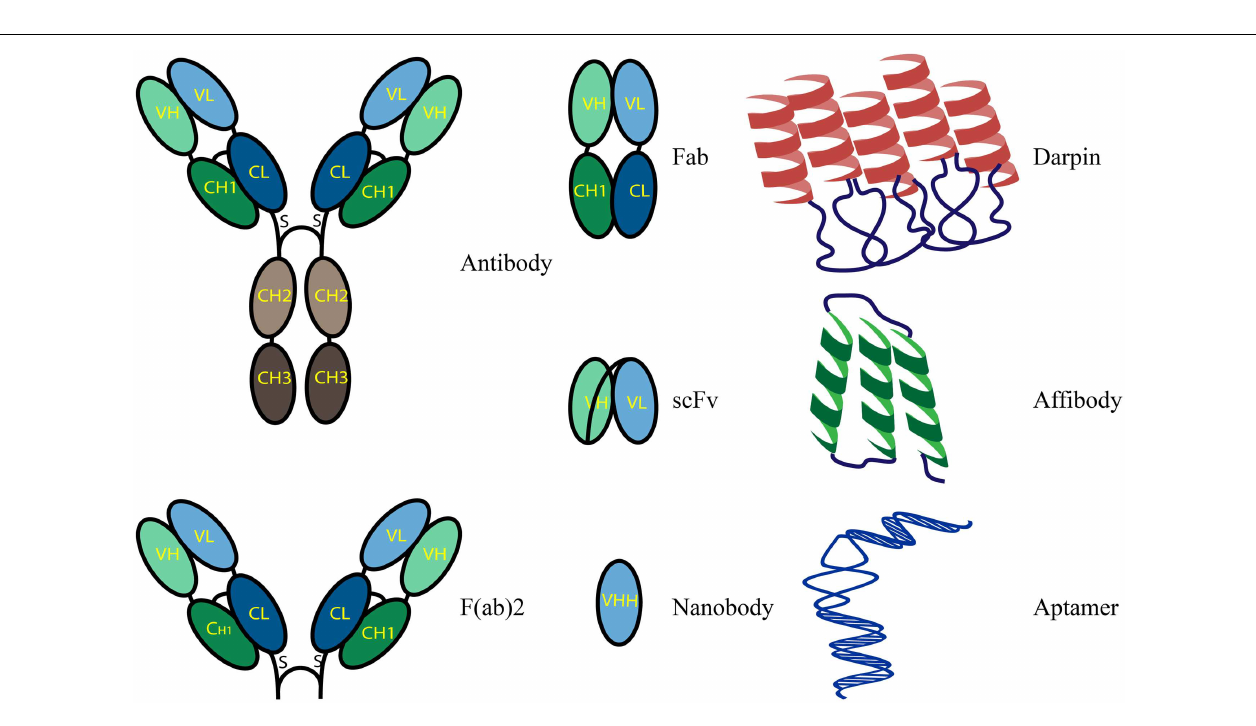
FIGURE 2 | Schematic representation of binder formats